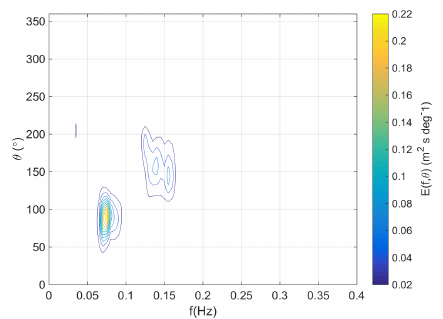
Figure 8. Directional wave spectrum for example given in Figure 9. Directional wave spectrum is estimated using a directional TRIAXYS wave rider buoy.